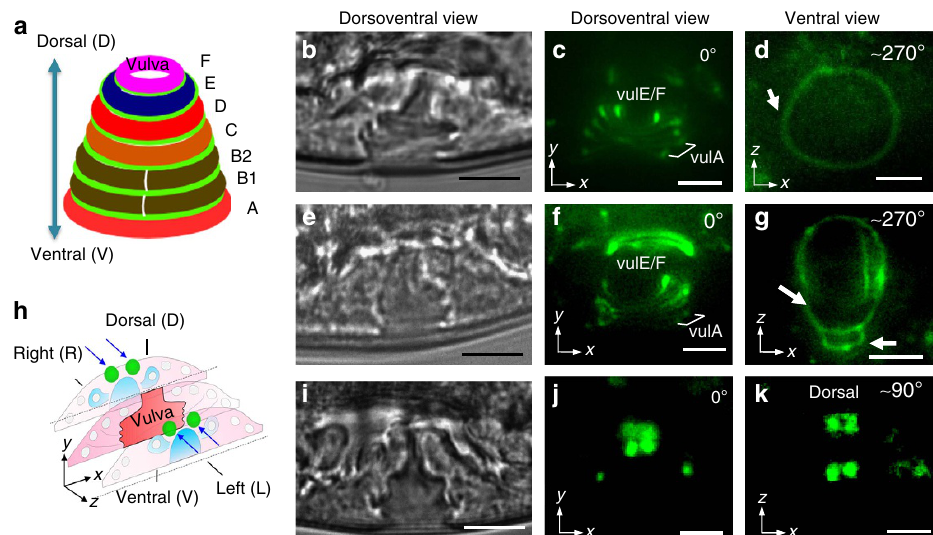
Figure 6 | Toroid formation and cell position during C. elegans reproductive system morphogenesis. ( a ) A schematic of vulva structure of a C. elegans showing seven concentric toroidal rings, VulA to VulF along the dorsoventral positional axis, connected by adherens junctions shown in green. Digital image of a vulva of ( b , i ) a wild-type animal and ( e ) an nhr-25(RNAi) animal. Fluorescence image of toroids created by visualization of the space between AJM-1::GFP adherens junction rings in ( c ) a wild-type and ( f ) an nhr-25(RNAi) animal acoustically driven along the dorsoventral axis. ( d ) The ventral view of an ARM rotated worm showing shape and size of border of vulA in wild-type and ( g ) in nhr-25(RNAi) animals. In the nhr-25(RNAi) animal, the vulA border is expanded laterally and abnormal adherens junctions (arrows) were seen. ( h ) A schematic of vulva epithelial cell positions along the left and right axis. Two VulF cells on the right and two on the left shown in green. ( j ) Dorsoventral view shows two GFP þ cells. ( k ) Ventral view obtained through ARM clearly shows four GFP þ cells. Scale bars, 10 m m.